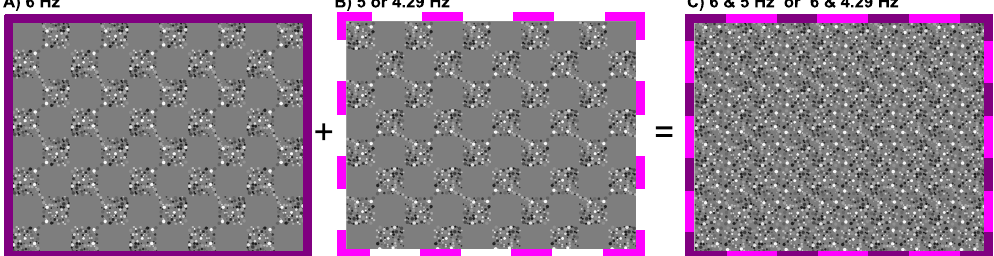
Figure 7. Frequency tagging. An example of one of the image pairs of the P2 condition, which was tagged with two different frequencies. ( A ) The solid purple frame indicates that the first half of the image pair was tagged with 6 Hz. ( B ) The dashed pink frame indicates that the second half of the image pair was tagged with either 5 or 4.29 Hz. Please note that purple/pink lines are only drawn here to explain the symmetry configurations and the frequency tagging method and are not a part of the stimulus presentation. ( C ) By combining these two image pairs, we generated a wallpaper pattern which consists of two frequencies, indicated here as the combination of purple and pink